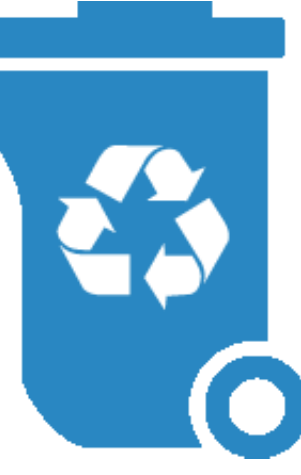
Figure 9. Sample Sign # 1.